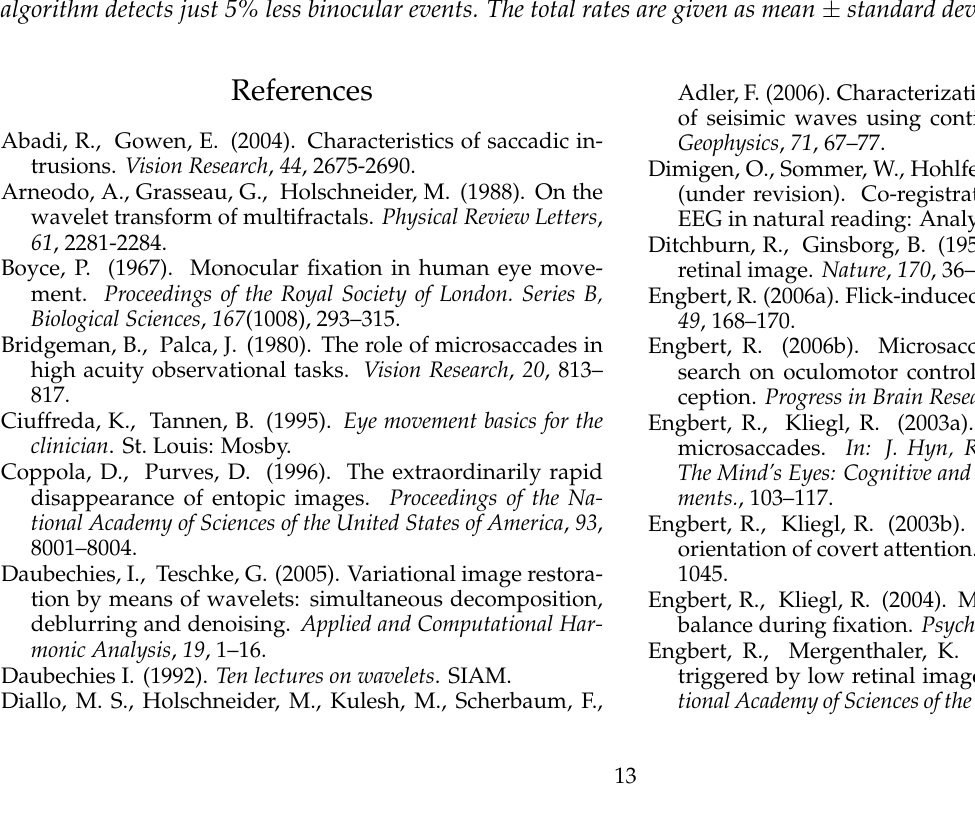
Detection of microsaccadic events in a fixational eye movement experiment with the continuous wavelet transform (WT) and velocity threshold (VT) method. Results are compared after application of the individual settings for each method. The VT algorithm detects just 5% less binocular events. The total rates are given as mean ± standard